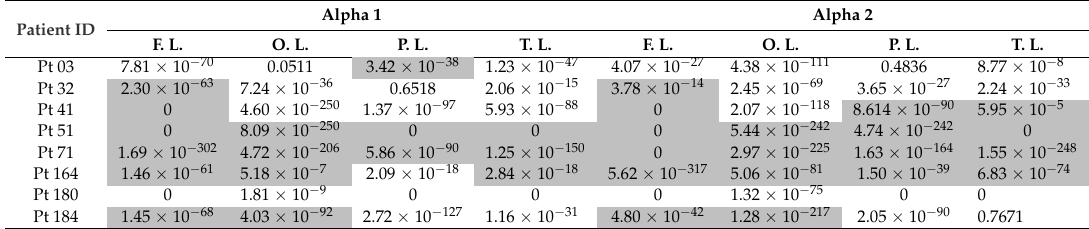
Table A2. p-values resulting from the Wilcoxon rank sum test for alpha 1 and alpha 2 sub-bands.